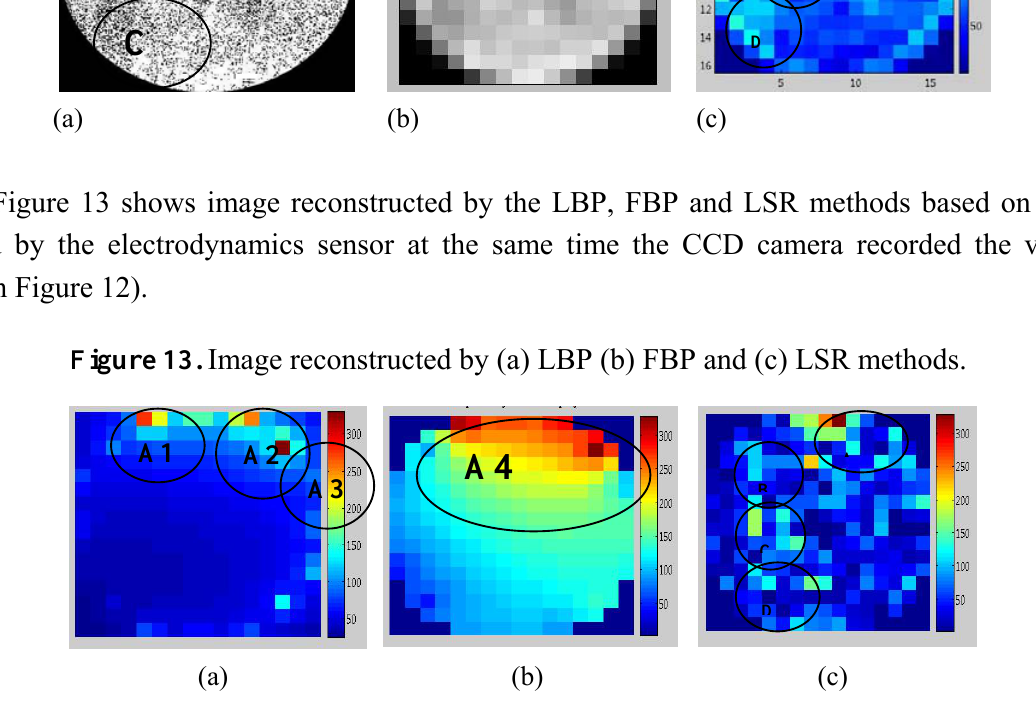
Figure 13. Image reconstructed by (a) LBP (b) FBP and (c) LSR methods.